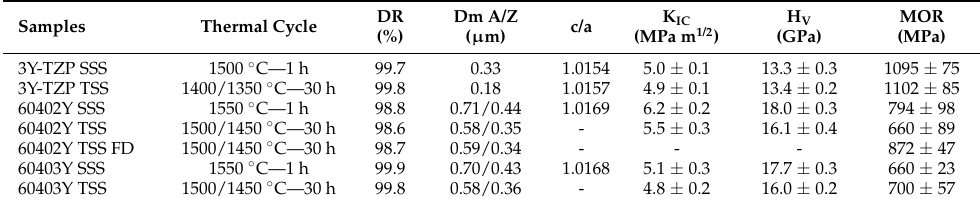
Table 5. Properties of 3Y-TZP and ZTA materials sintered with the single step (SSS) or two-step cycles (TSS). DR is the relative density, K IC the fracture toughness, H V the microhardness, MOR is the four-point flexural strength, Dm is the average grain size (A refers to alumina and Z to zirconia grains), and c/a is the